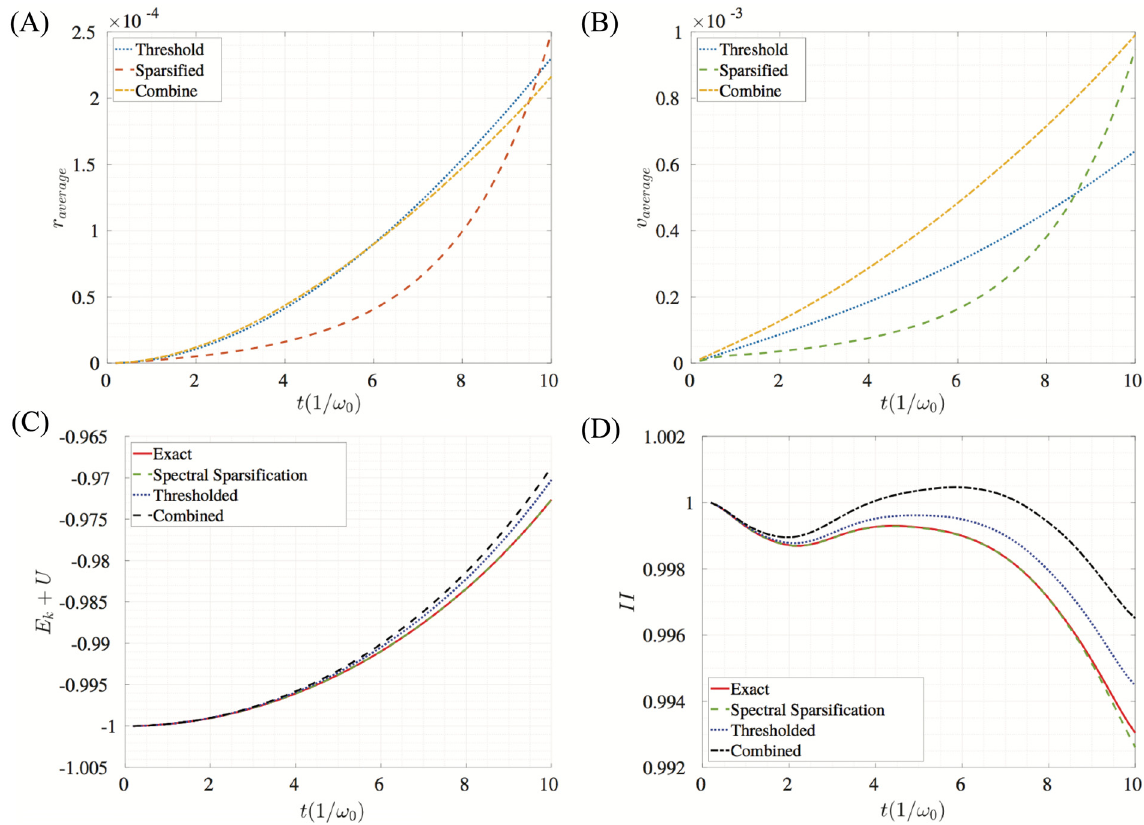
Fig 6. Measures of error and global properties for the sparsified, thresholded, and combined approximations for the tensile simulations. Errors are calculated by comparing sparsified networks to a network with no edge reduction. The network with no sparsification is labeled as exact. (A) Average difference in position between the exact solution and the approximation solutions. (B) Average difference in velocity between the exact solution and the approximation methods. (C) Potential energy, kinetic energy, and total energy of the system for the different methods. Note that there is about a half of unit difference between the thresholded (and combined) total energy and the exact (and sparsified) total energy. (D) Normalized second invariant of the stress tensor.